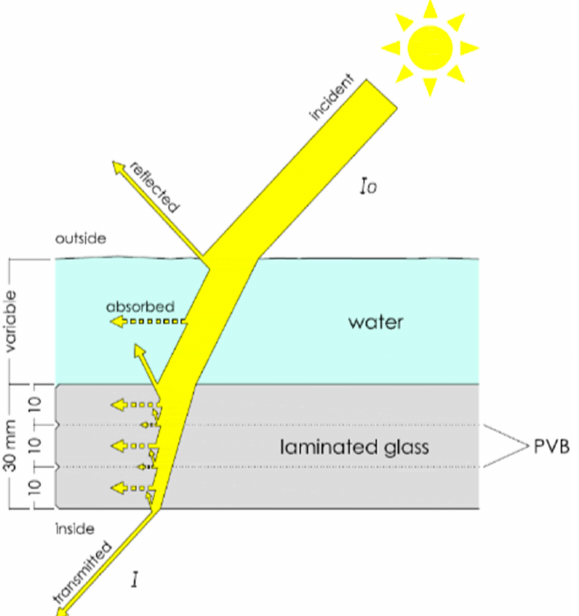
Figure 1. Diagram of optical relative attenuation through skylight and water layer. The initial intensity ( I 0 ) is reduced by the partial absorption and reflection experienced when passing through different layers, meaning that only a fraction is transmitted to the interior ( I ).